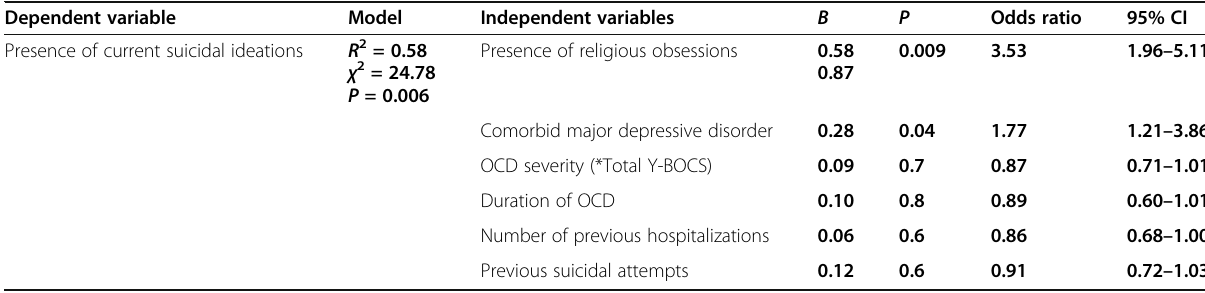
Table 3 Logistic regression analysis predicting presence of current suicidal ideations among patients with OCD ( N =